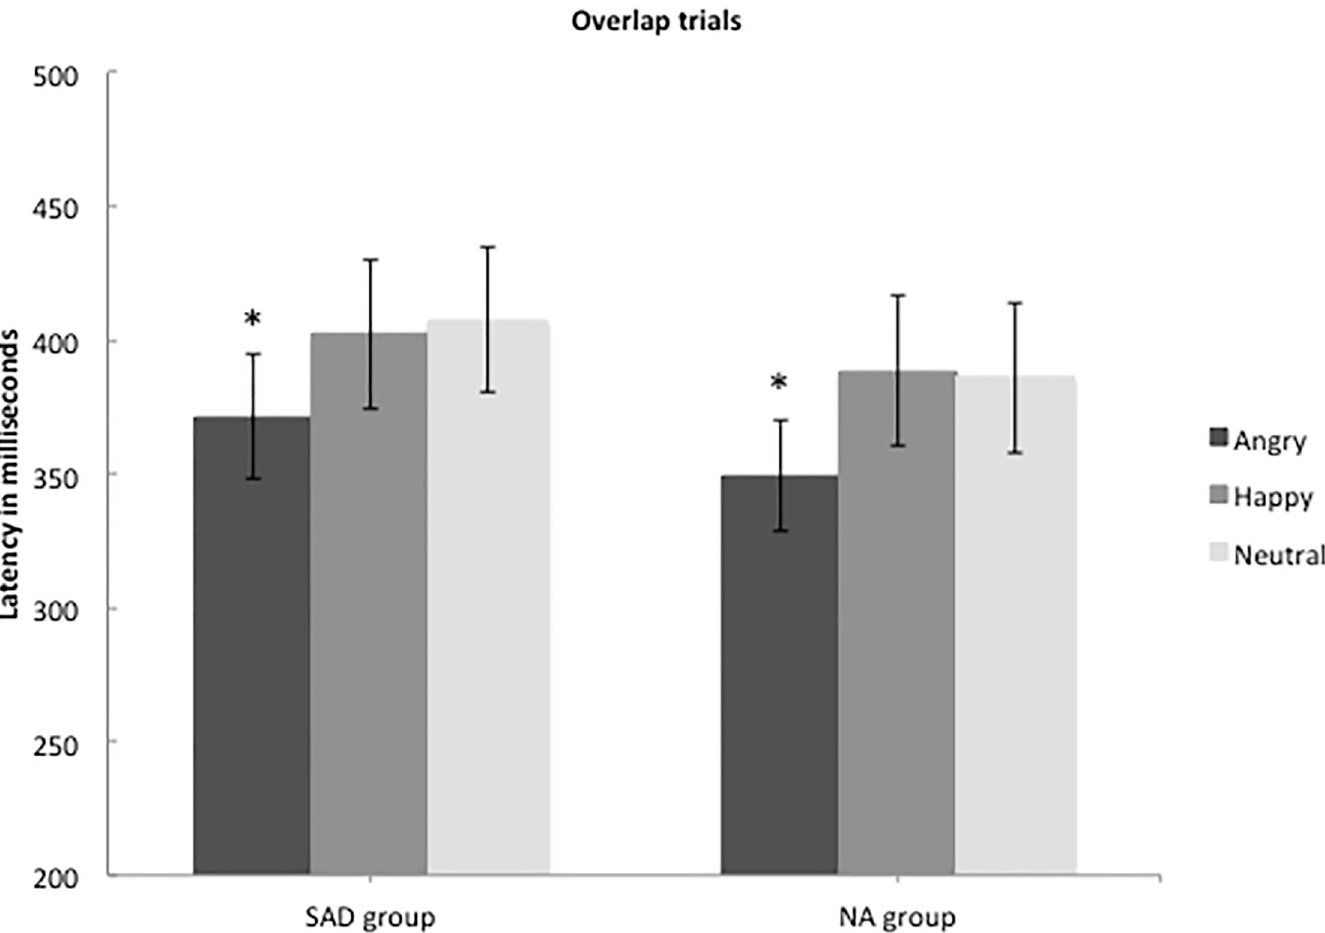
Fig 4. Mean time in milliseconds (with 95% confidence intervals) to direct gaze away from a centrally located social stimulus, with different emotional valences. For the social anxiety group ( N = 25) and the non-anxious group ( N = 22).